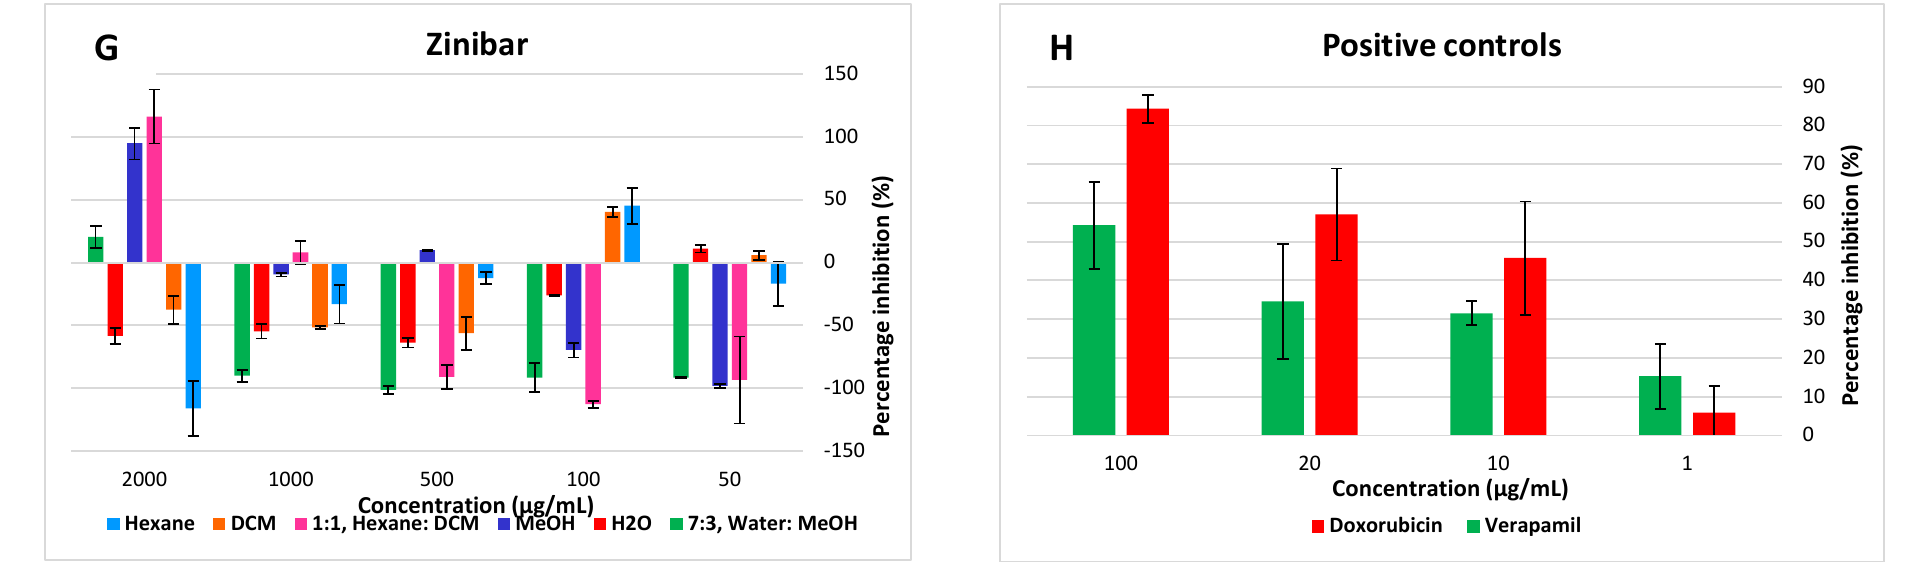
Figure 5. Cytotoxicity and cell proliferation on normal human HEK293 liver cells over 24 h exposure of tested indigenous tea plants with trade names (( A ) Haw Haw; ( B ) Gancair; ( C ) Moologa; ( D ) Mosukujane; ( E ) Resurrection bush; ( F ) Tinar; ( G ) Zinibar. ( H ). Positive controls).